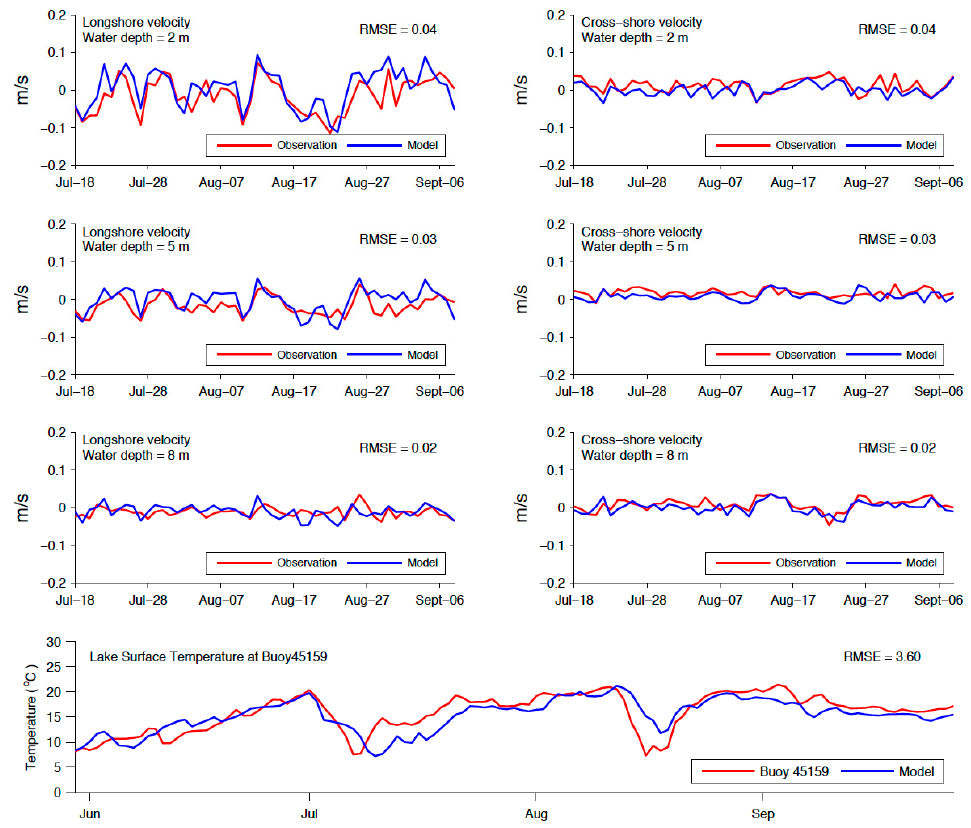
Figure 6. Comparison of model output with ADCP measurements of daily averaged longshore and cross-shore currents at depths of 2 m (near surface), 5 m (middle layer), and 8 m (near bottom). Comparisons of model output and measurements of the daily average lake surface temperature at the NDBC Buoy 45159 location are presented in the bottom panel (only surface water temperature is available at the buoy location).